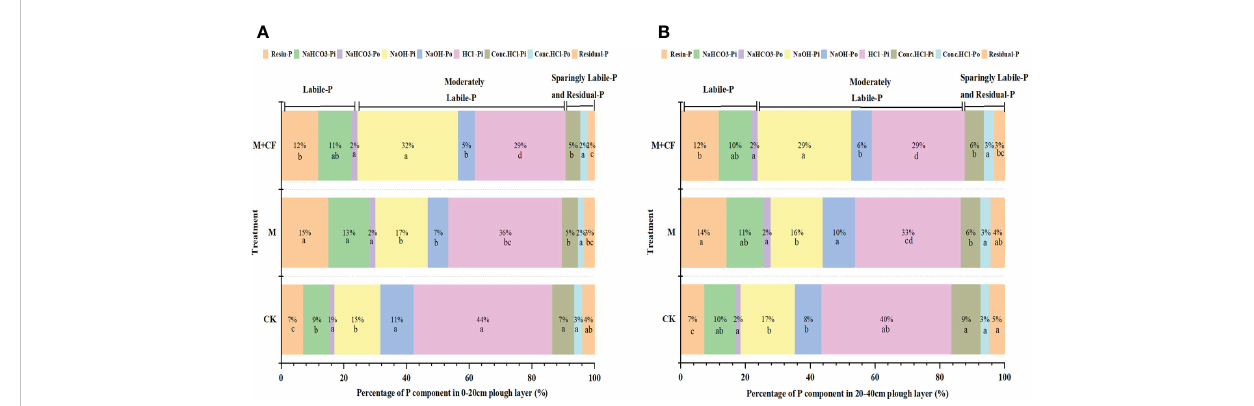
FIGURE 3 The proportion of P activity classi fi cation in response to different fertilizer applications at two soil layers. Labile-P: Resin-P, NaHCO 3 -P i , NaHCO 3 -P o ; Moderately Labile-P: NaOH-P i , NaOH-P o , HCl-P i , Sparingly Labile-P: Conc.HCl-P i , Conc.HCl-P o and Residual-P. (A) represent 0-20cm soil layers, and (B) represent 20-40cm soil layers. Below the proportion, lowercase letters indicate signi fi cant differences at P<0.05 of the same indicators (3 treatments)at two soil layers.